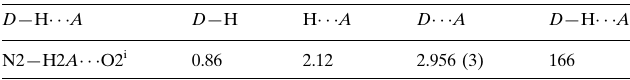
Hydrogen-bond geometry (A˚ , (cid:2)